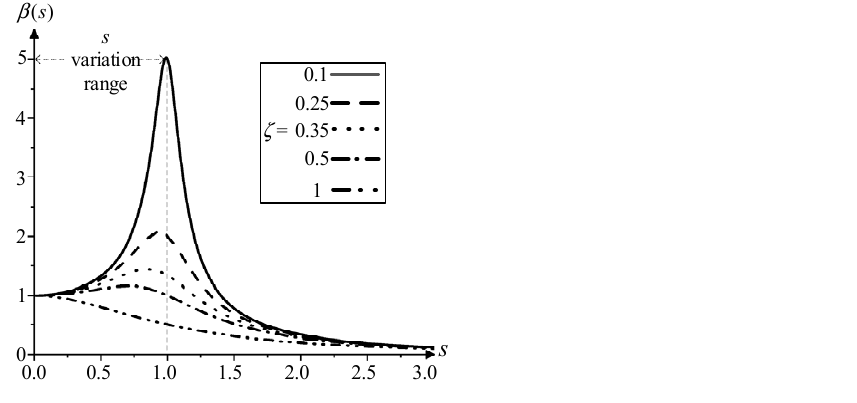
Figure 2. Steady-state response curve of amplitude amplification factor.